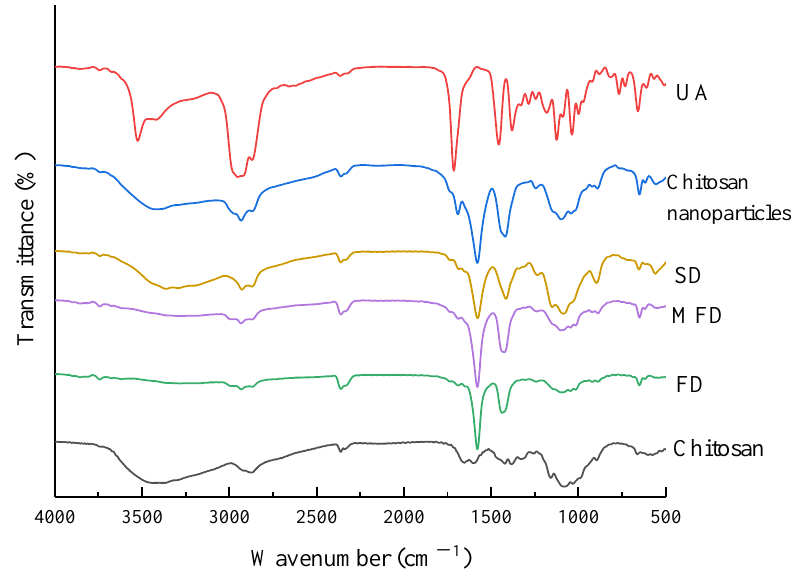
Figure 2. FT-IR spectra of chitosan, UA, chitosan nanoparticles, freeze-, microwave freeze-, and spray-dried UA-loaded chitosan nanoparticles. UA-loaded chitosan nanoparticles prepared by freeze drying (FD), microwave freeze drying (MFD) and spray drying (SD). UA: ursolic acid.